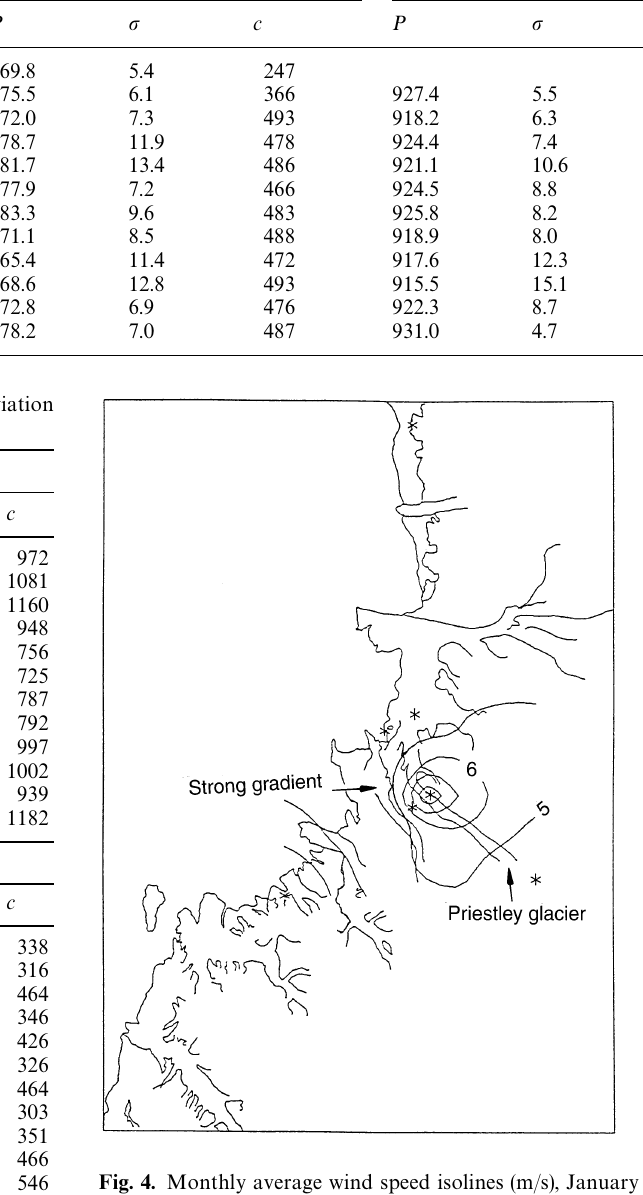
temperatures, due to intense solar radiation and ocean heat storage capacity, while winter temperatures at high- altitude inner areas are much lower than sea-ice temper- atures. The relation between annual temperature averages ( ° C) and height (m) is linear; the best fit is: